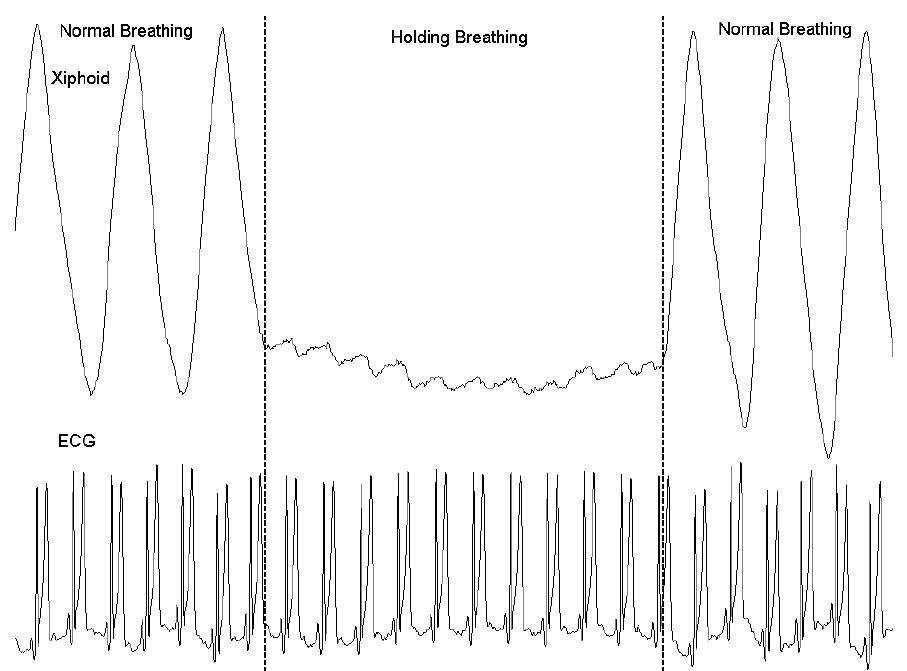
Figure 10. RIP band signals at the level of the xiphoid and ECG during normal breathing and simulated breath